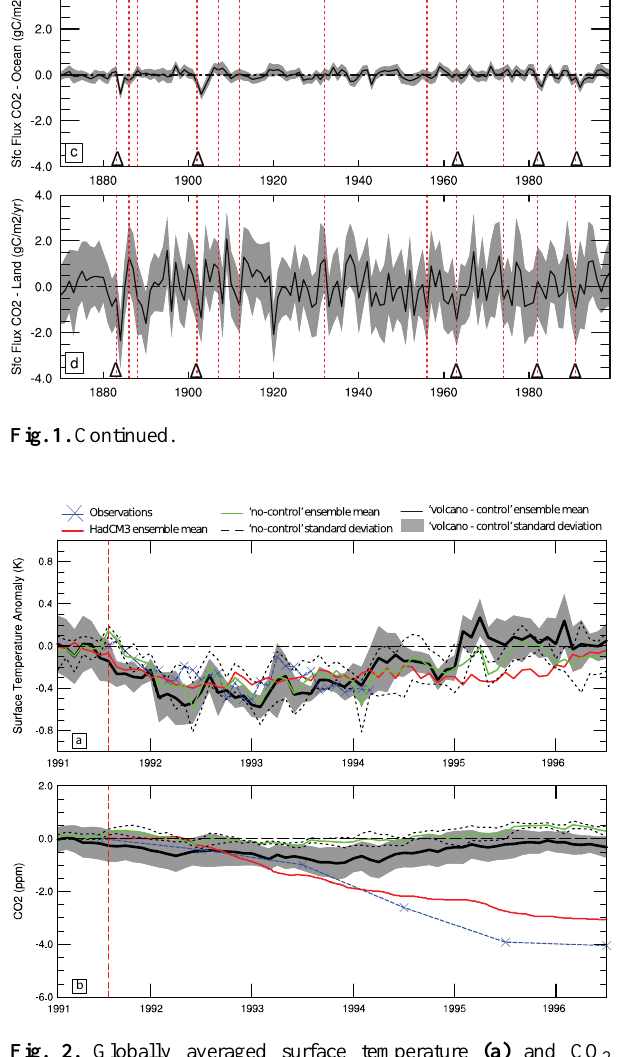
Fig. 2. Globally averaged surface temperature (a) and CO 2 (b) anomalies following the eruption of Mt. Pinatubo in 1991 (de- noted with a vertical, dashed red line). HadCM3 data (red curve) is from Jones and Cox (2001). Observational data (blue curve with “x” markers) for temperature is from Jones and Kelly (1996); the CO 2 observations are the anomalies in atmospheric CO 2 at Mauna Loa attributed to volcanic forcing, as estimated in Jones and Cox (2001). Also plotted are anomalies computed using the CCSM3 model with both the “volcano–control” and “no-control”